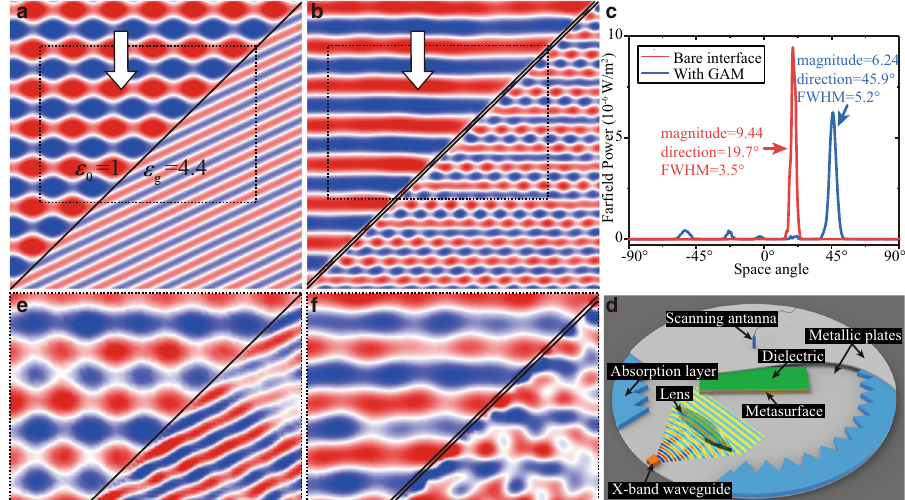
Fig. 3 Simultaneous elimination of the re fl ection and refraction effects on a dielectric surface by the GAM. a , b Simulated E z fi eld distributions for a dielectric surface without ( a ) and with ( b ) the designed GAM under illumination of a TE-polarized wave with the incident angle of 45 (cid:3) . c Simulated far- fi eld radiation power pattern in the half-in fi nite space of dielectric material. d Schematic diagram of the experimental setup. e , f Experimentally measured E z fi eld distributions for the dielectric surface without ( e ) and with ( f ) the GAM in the regions marked by the dotted box shown in ( a ) and ( b ),